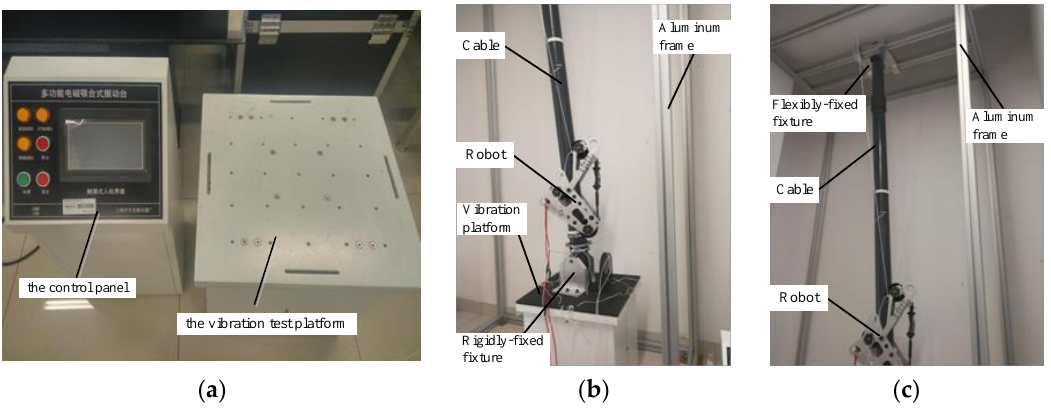
Figure 14. Vibration test platform. ( a ) Electromagnetic vibrator; ( b ) Lower rigidly-fixed fixture; ( c ) Upper flexibly-fixed fixture.